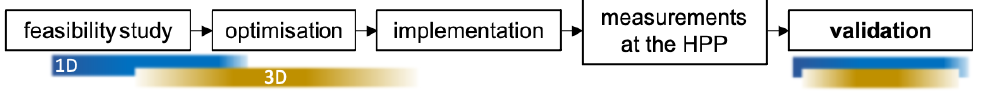
Figure 3. Methodological overview, from the initial feasibility study to the final validation and usage of the 1D and 3D-numerical